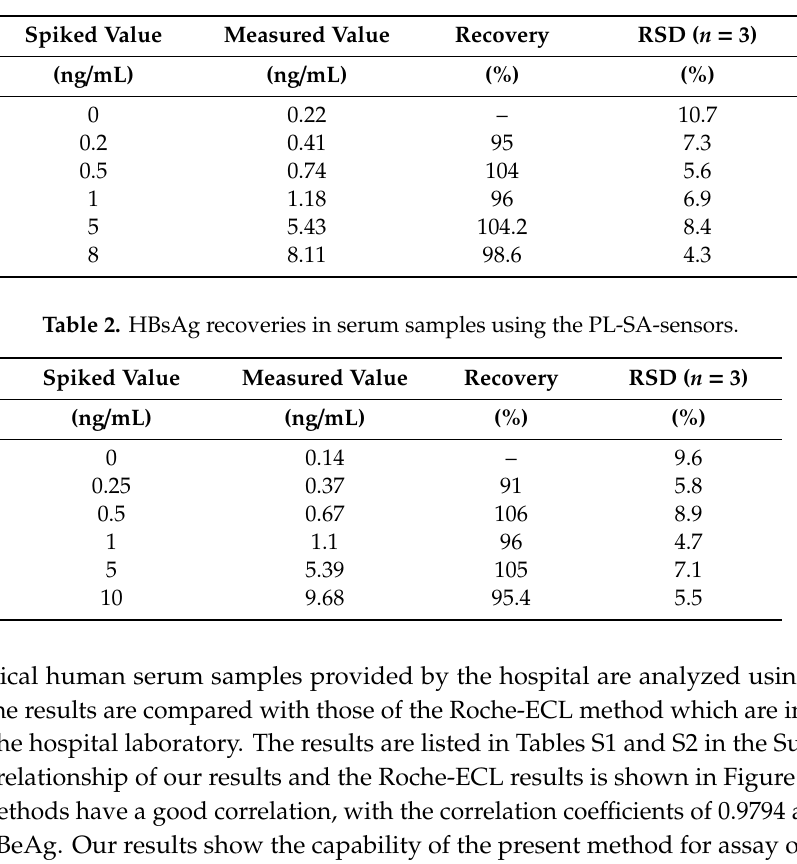
Table 1. HBeAg recoveries in serum samples using the PL-SA-sensors.